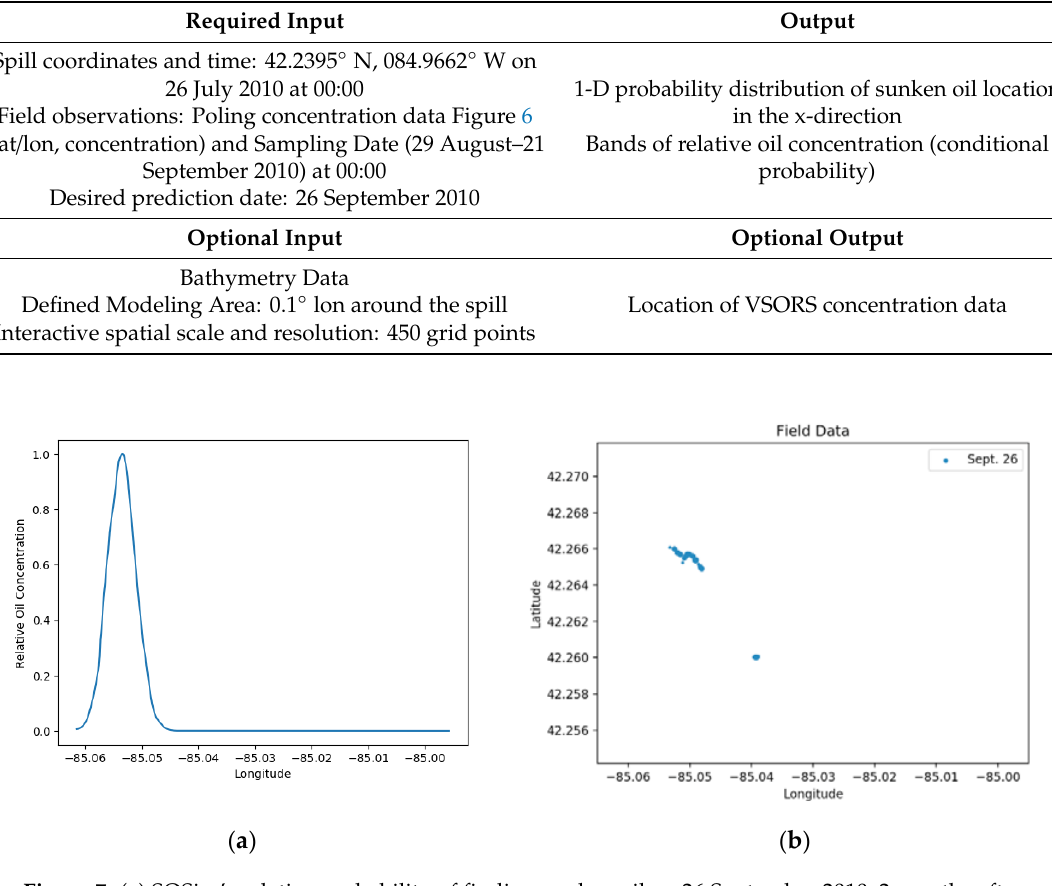
Figure 7. ( a ) SOSim’s relative probability of finding sunken oil on 26 September 2010, 2 months after the Enbridge Kalamazoo River spill; ( b ) location of field observations on 26 September 2010, 2 months after the Enbridge Kalamazoo River spill.